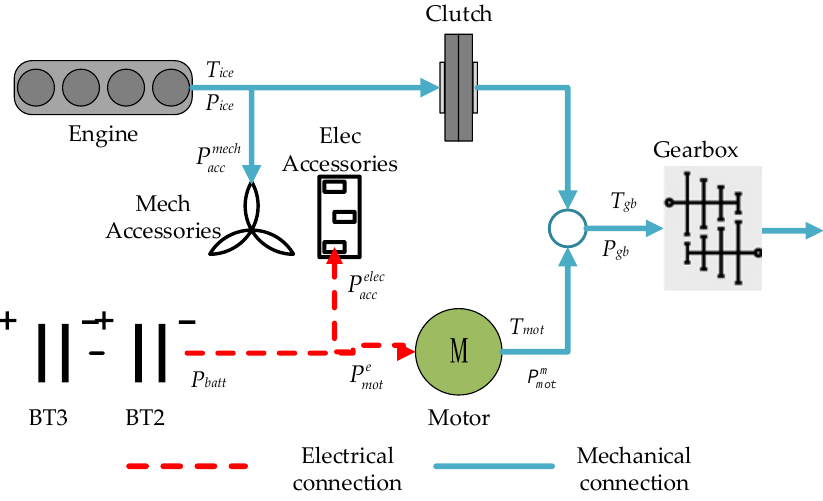
Figure 1. Power flow diagram of parallel HEVs .